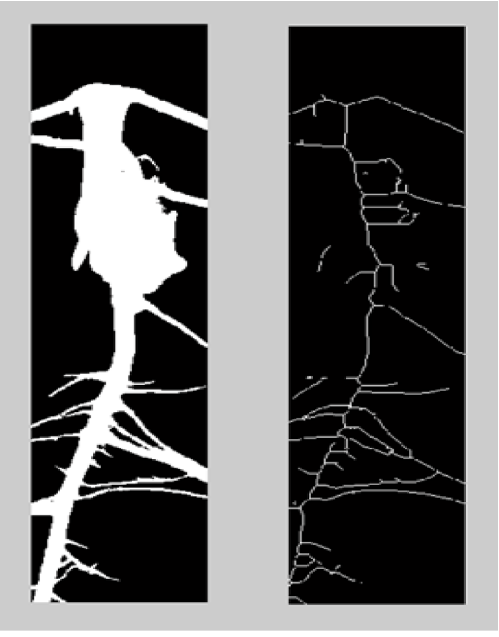
Figure 7. Thresholding and skeletonization stages.